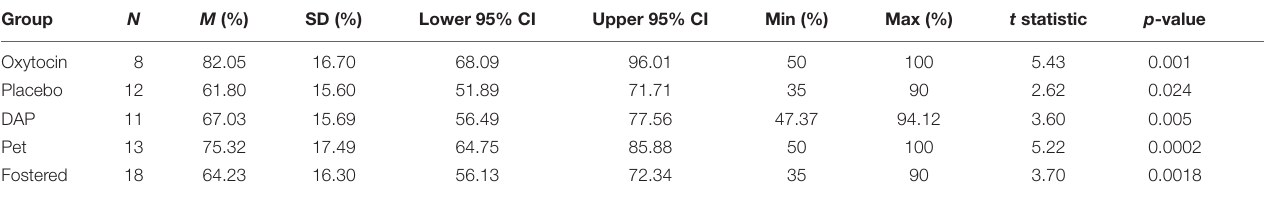
TABLE 8 | Mean percentage of correct choices made by dogs (that chose 10 or more times) in each treatment and recruitment group compared to chance (50%). Group